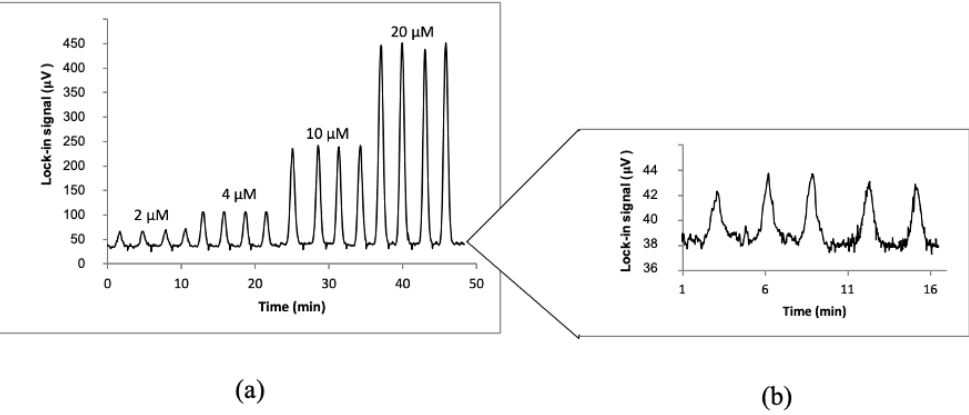
Figure 5. µ FIA-TLM signals for four replicate injections of four concentration levels of Fe(II) (sample injection volume: 3 µ L, carrier flow rate: 5 µ L/min) ( a ). The insert ( b ) on the right shows an expanded view of signals for injections of the blank.